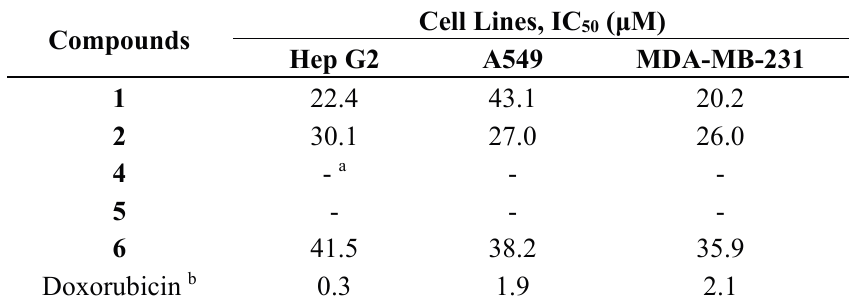
Table 2. Cytotoxicity data of compounds 1 , 2 and 4 – 6 .